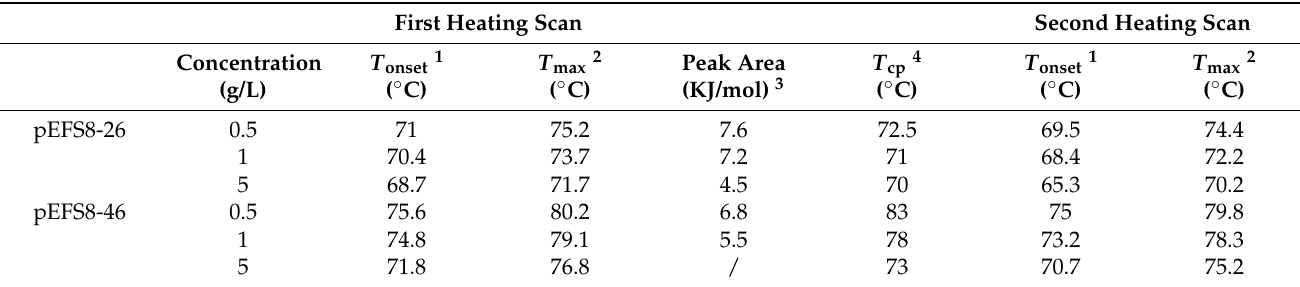
Table 3. Calorimetric data for pEFS8-x